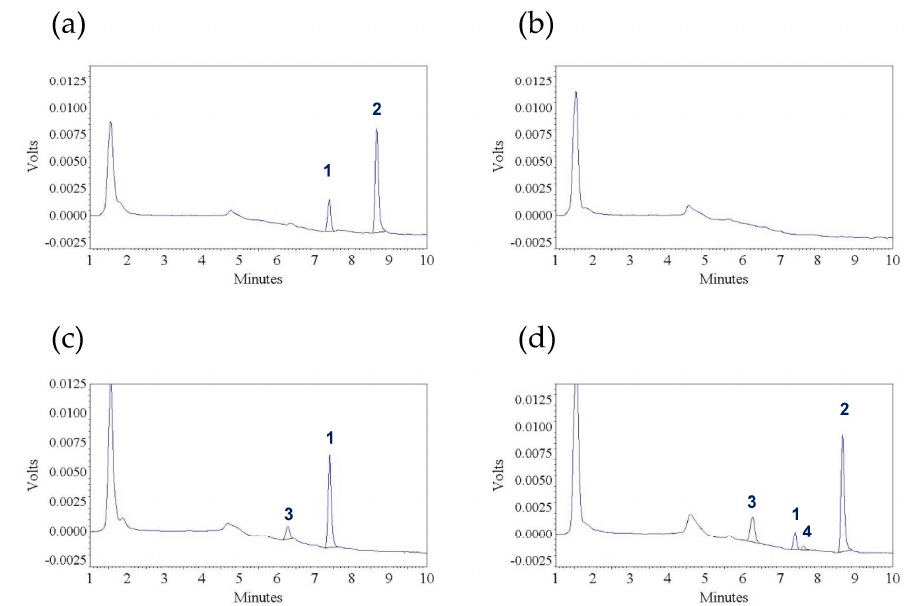
Figure 2. Representative chromatograms (UV absorbance, λ = 312 nm) of: ( a ) a blank plasma sample spiked with tangeretin (300 ng/mL) and trans -stilbene (internal standard) (900 ng/mL); ( b ) a pre-dosing plasma sample; ( c ) a post-dosing plasma sample collected from a Sprague—Dawley rat at 30 min after receiving an intravenous dose of tangeretin (10 mg/kg) (without internal standard); and ( d ) a post-dosing plasma sample collected from a Sprague—Dawley rat at 30 min after receiving an oral solution of tangeretin (50 mg/kg) (with internal standard). Peak 1: tangeretin, peak 2: trans -stilbene (internal standard), peaks 3 and 4: unidentified metabolites.